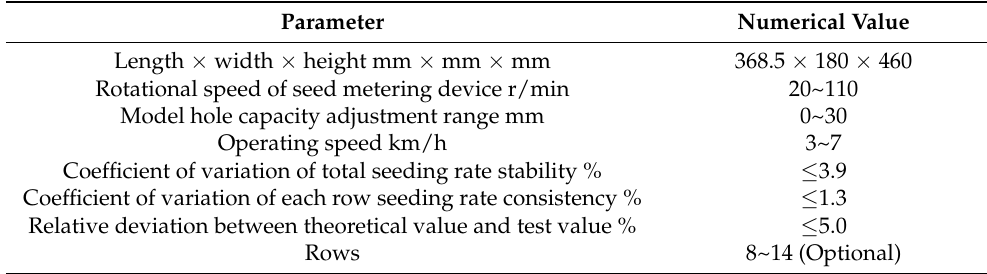
Table 1. The main technical parameters of inverted-fin-shape model-hole-wheel variable seed metering device for wheat.